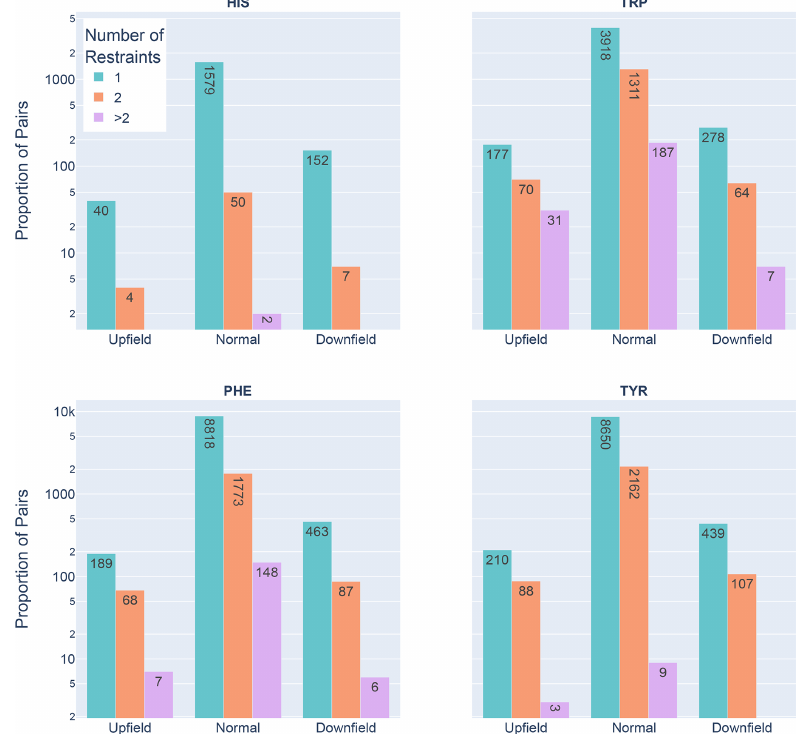
Figure 6. Shown are the number of restrained amide–aromatic pairs (that is amide protons and aromatic rings with at least one defined restraint between them) for the four aromatic residue types and three Z score classifications: upfield ( Z ≤ − 2), downfield ( Z ≥ 2), and normal ( − 2 ≤ Z ≤ 2). The colors of the bars correspond to the number of restraints between the pairs; bar heights are plotted using a logarithmic scale.